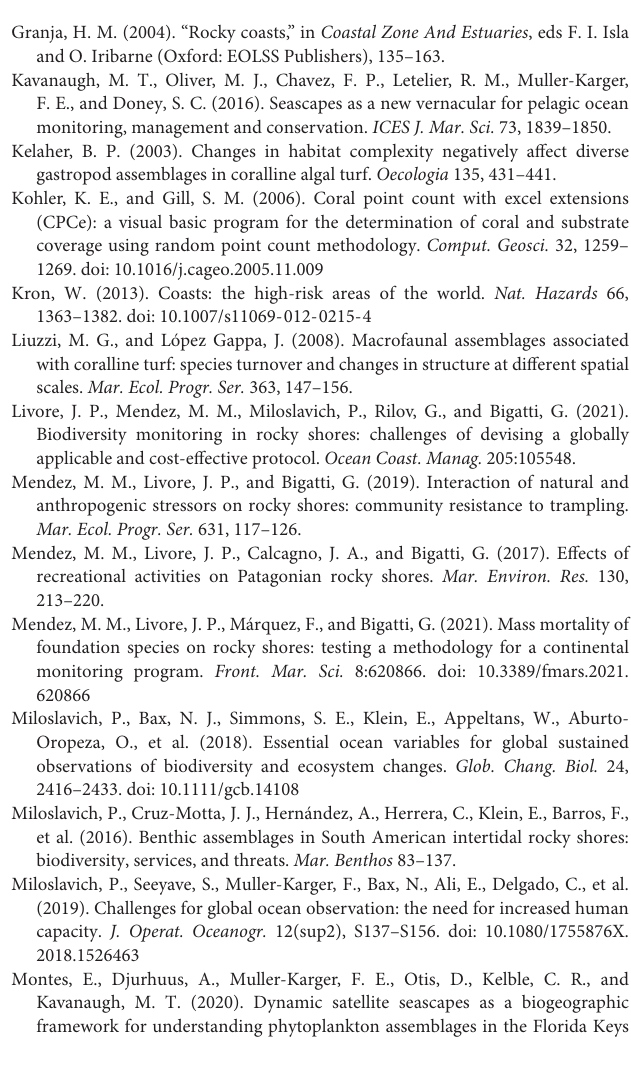
Supplementary Table 1 | List of environmental variables used in